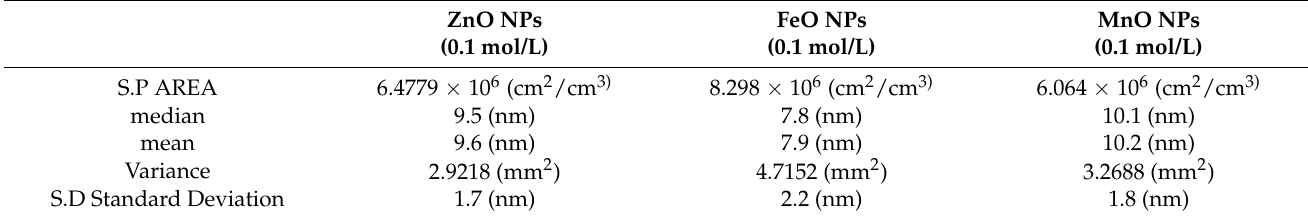
Figure 4. ( a ) Zinc oxide nanoparticles (ZnO NPs), 0.1 mol/L; ( b ) iron oxide nanoparticles (III) (FeO